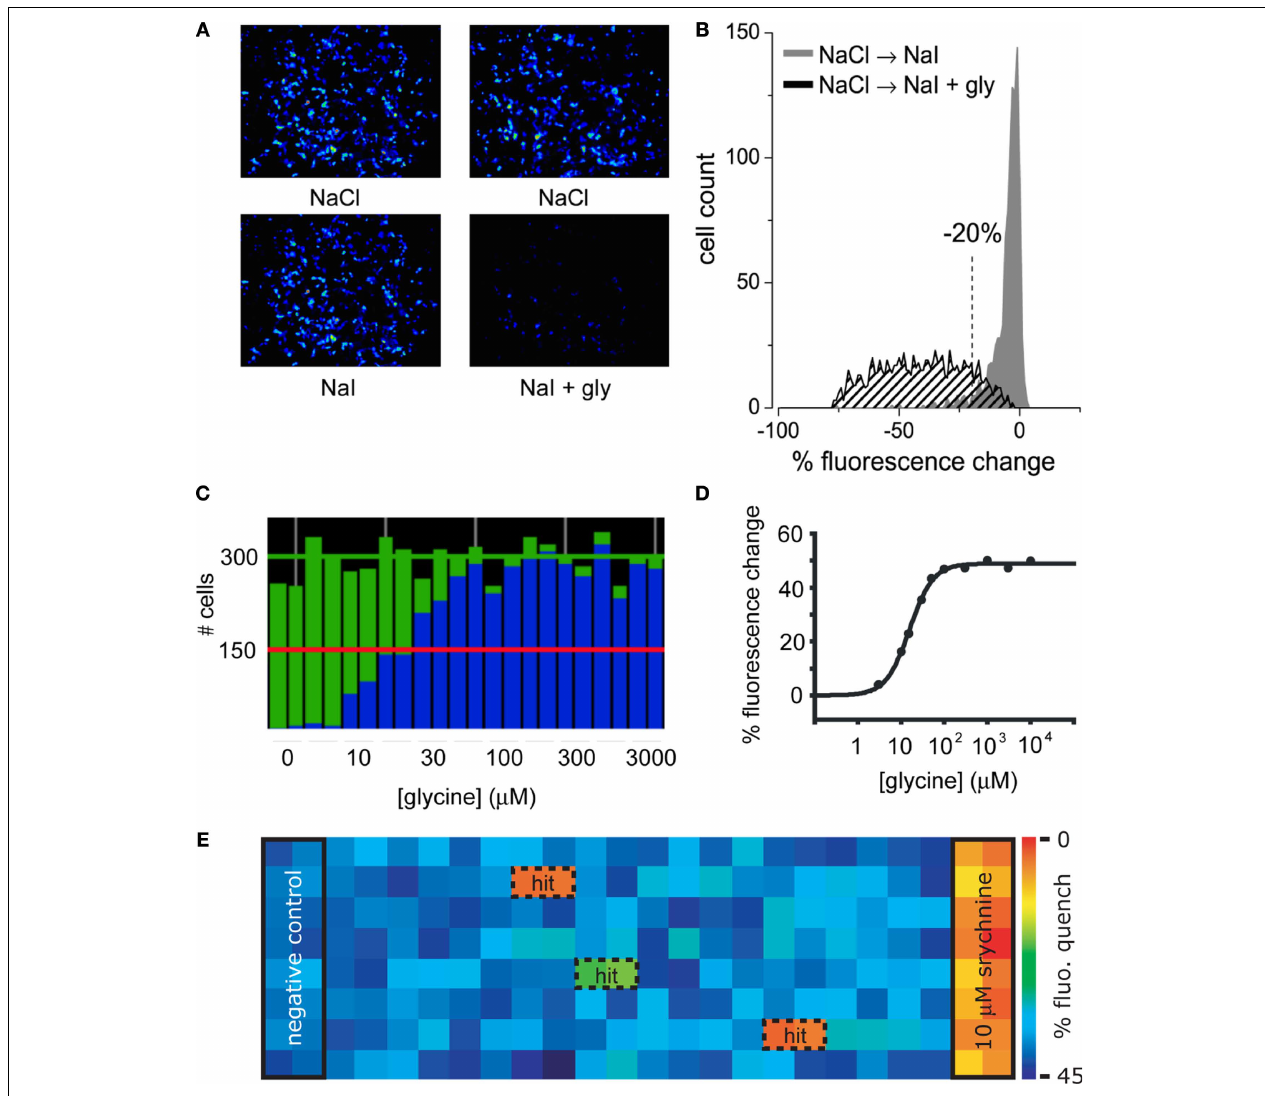
well that quenched by > 20% upon glycine addition. From left, glycine concentrations were (in µM): 0, 3, 10, 15, 30, 50, 100, 300, 1000, 3000. Each was applied to two wells and every second value is shown. (D) Mean percentage fl uorescence change of all fl uorescent cells in (C) plotted against glycine concentration. Fitted EC = 22 µM. (E) ‘Heatmap’ of an actual 50 screening experiment comprising eight rows of a 384-well plate, with ‘hits’ (i.e., fractions producing antagonistic activity) boxed and labelled. Experimental design is described in the